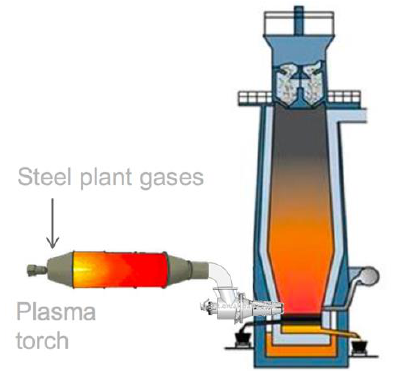
Figure 21. The ULCOS solutions and their present status.